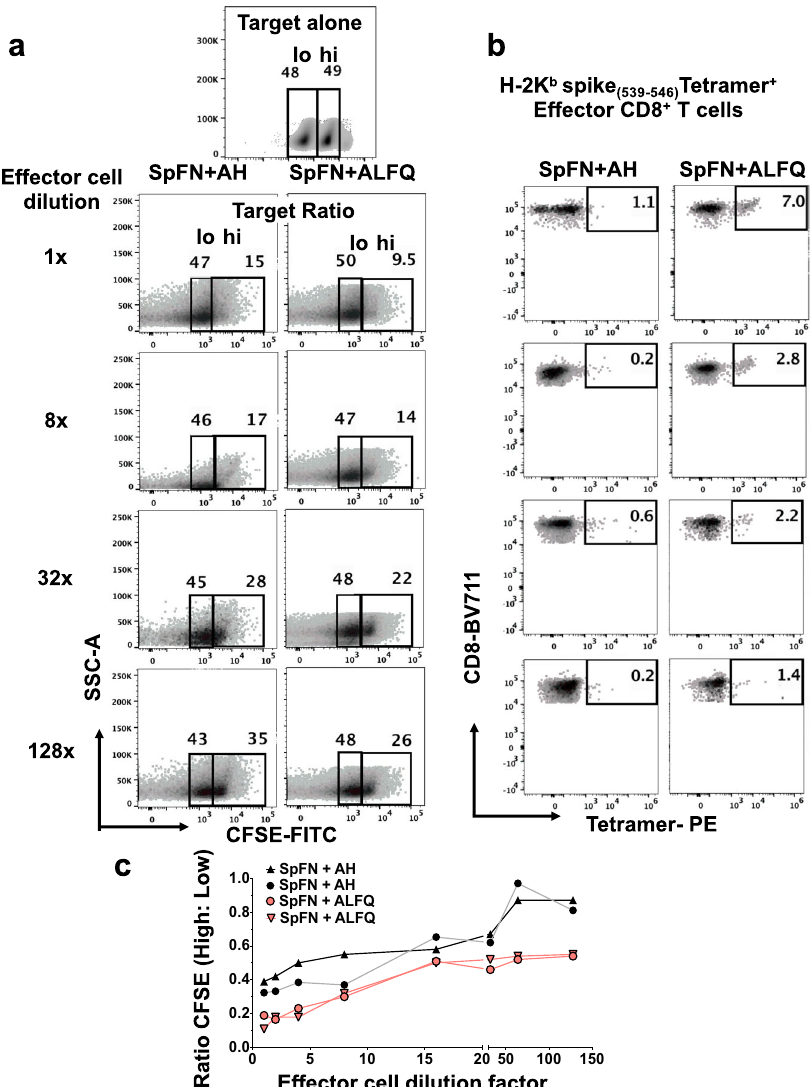
Fig. 9 Flow cytometry-based CFSE cytotoxic T cell (CTL) assay to measure antigen-speci fi c killing in response to SpFN vaccine at week 6 following prime-boost vaccination. Flow cytometry plots depicting the frequency of a CFSE-high/CFSE-low population and b effector cells from the spleens of mice vaccinated with SpFN vaccine adjuvanted with ALFQ or AH. c Graph depicting the ratio of CFSE high to low (indicating antigen-speci fi c killing) as a function of effector cell dilution. Each curve represents effector cell dilutions from a single mouse vaccinated with SpFN + ALFQ or SpFN + AH. The curves were evaluated using the Pearson correlation coef fi cient. Two independent experiments were performed and data from one of the experiments is